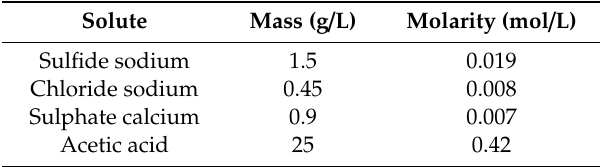
Figure 9. ( a ) Schematic view of the arrangement of the tension-loading system, and ( b ) a photograph. Table 4. Composition of the synthesized